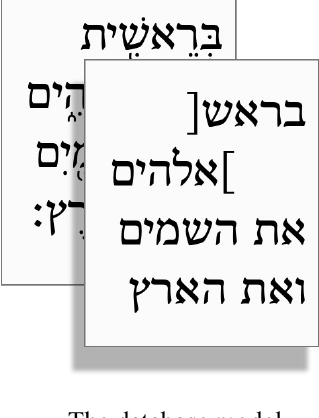
Figure 1: The reuse of database items in multiple contexts This structure means that instead of existing in one or two dimensions, as in the document model, texts in the database model exist in three dimensions. Rather than being constrained to setting them side by side for comparison, we can stack one on top of the other.